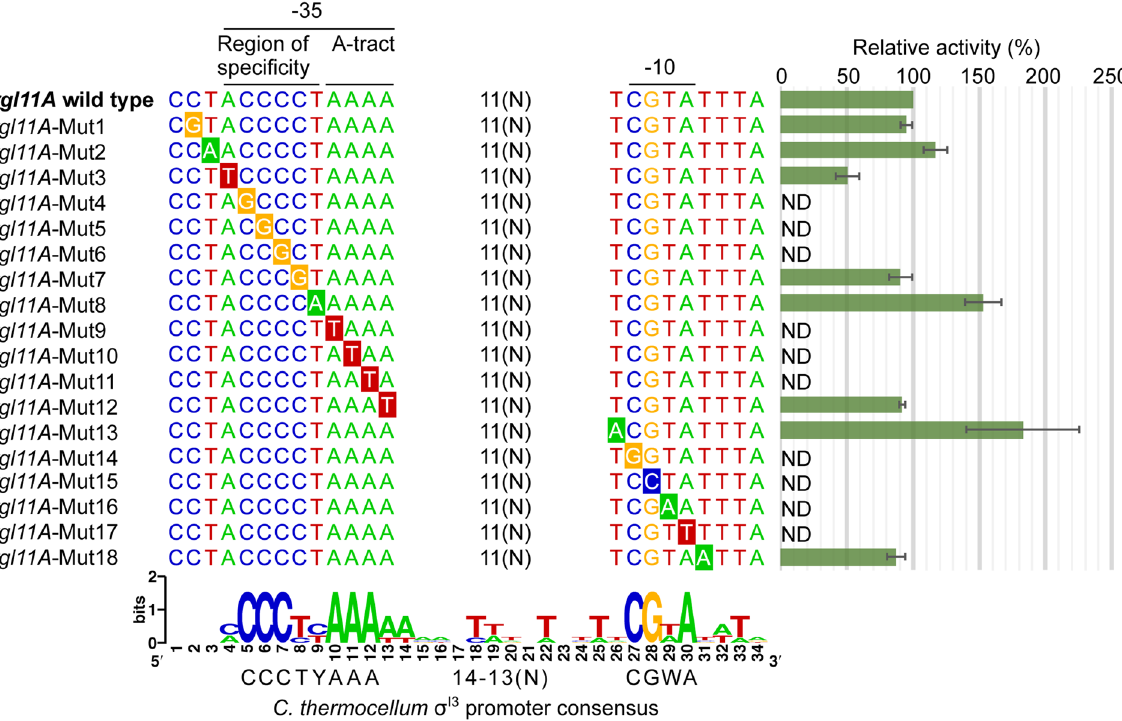
Figure 3. Evaluation of the validity of the σ I promoter motifs by mutagenesis. The rgl11 A σ I3 -dependent promoter was selected for this analysis, because it presented the highest activation by the C. thermocellum σ I3 factor 10 . The WebLogo was generated with σ I3 -dependent promoter sequences (Fig. 1A) and is shown to illustrate the effect of mutations in the most conserved nucleotides of the three motifs: (i) the − 10 promoter element, (ii) the A-tract motif and (iii) the region of specificity. Mutations are indicated by highlighted nucleotides, and the effect of each mutation is shown as relative activity, compared to that of the wild-type control promoter rgl11A , defined as 100%. The relative activity shown is the average of three independent experiments. Predicted − 35 and − 10 promoter elements are indicated by lines above the rgl11A promoter sequences. The nucleotide code Y represents C or T, W represents A or T, and N represents any nucleotide. ND means not